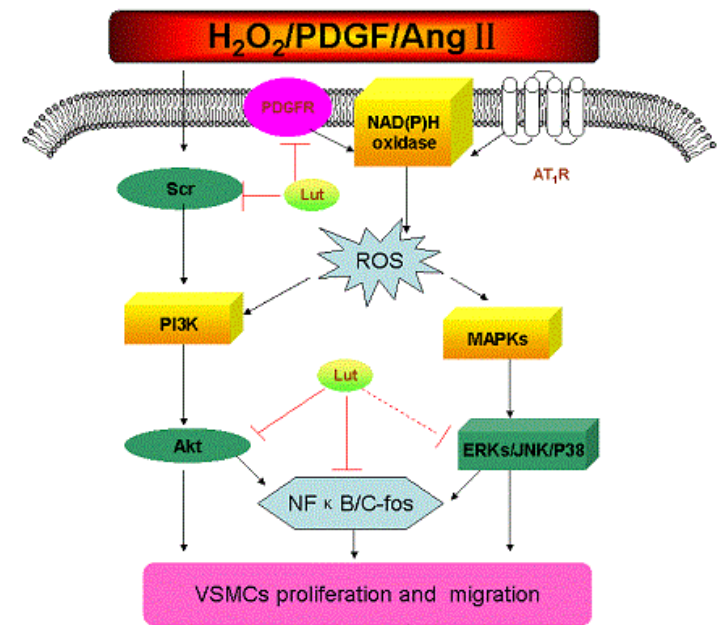
and migration. (AT 1R: angiotensin type 1 receptor; Lut: